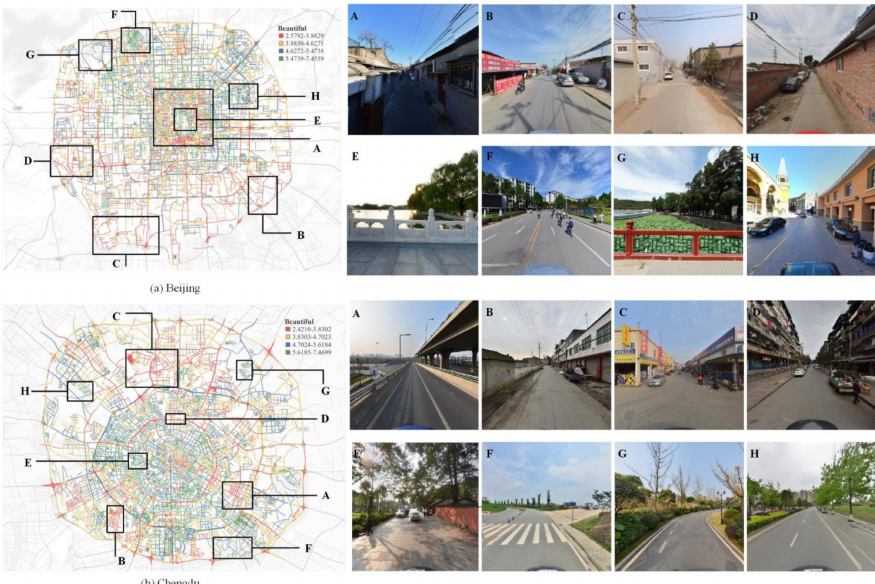
Figure 10. ( A – H ) Local analysis of the perceptual map, taking “beautiful” perception as an example and the image represents an example of the corresponding